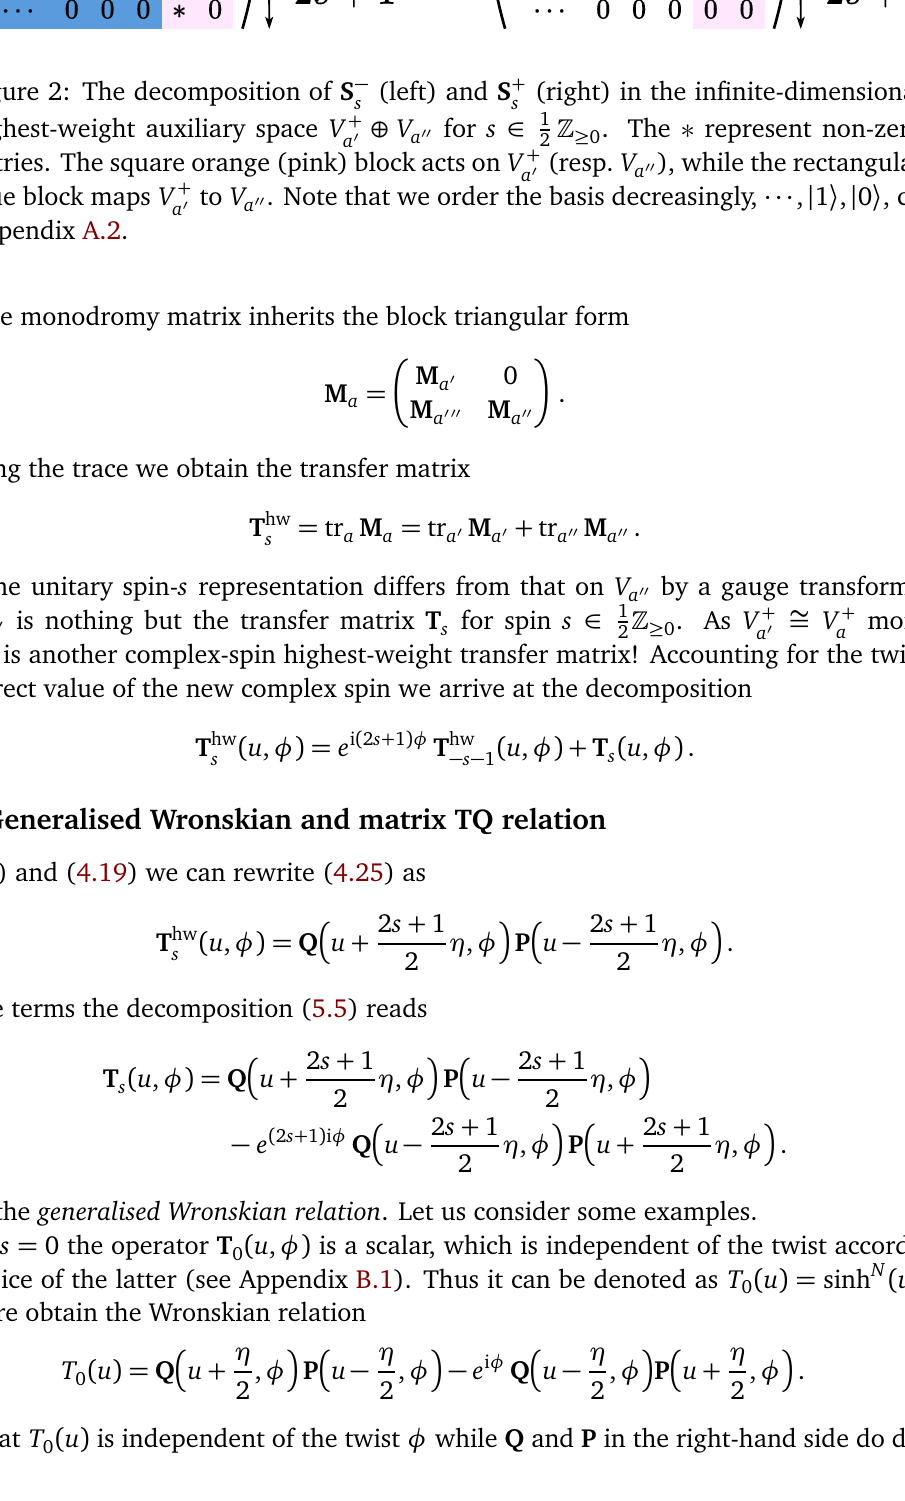
Figure 2: The decomposition of S − highest-weight auxiliary space V + entries. The square orange (pink) block acts on V + blue block maps V +